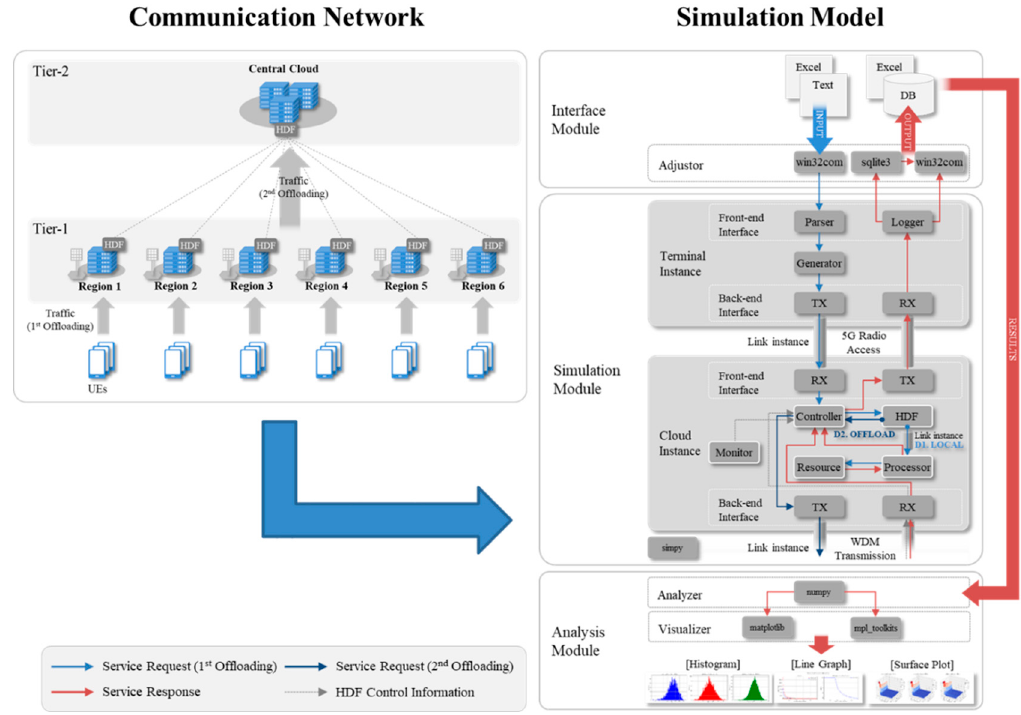
Figure 4. Network architecture simulation model.